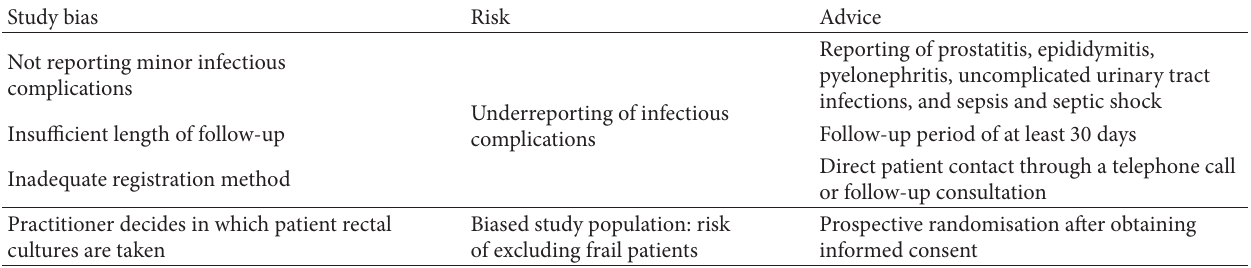
Table 2: Limitations of studies examining targeted therapy for prostate